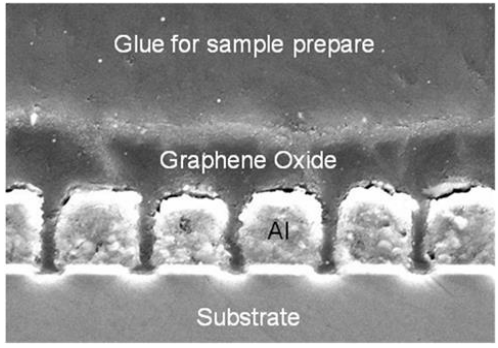
Figure 7. X-SEM photo of the sensor device after GO filling.